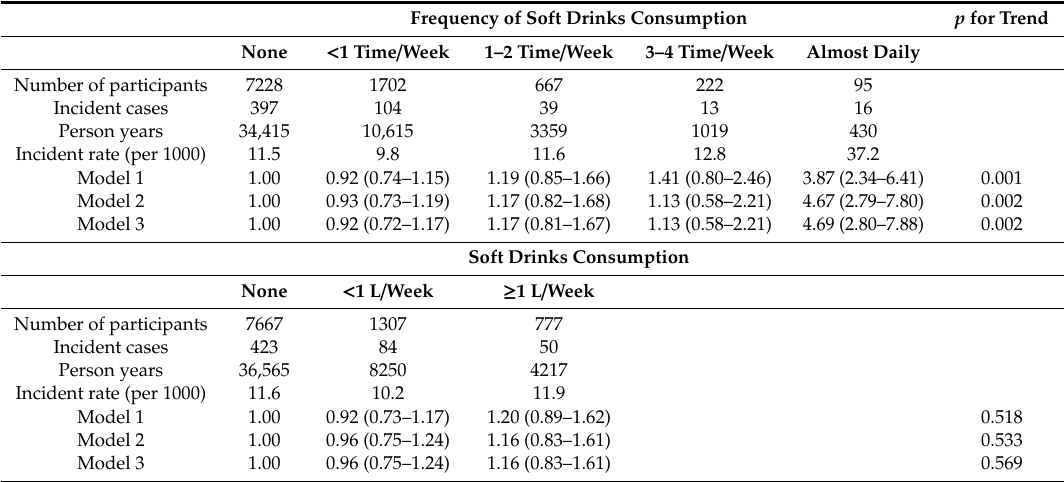
Table 3. Hazard ratio (95%CI) for fracture by soft drinks consumption levels among Chinese adults attending China Health and Nutrition Survey (N =